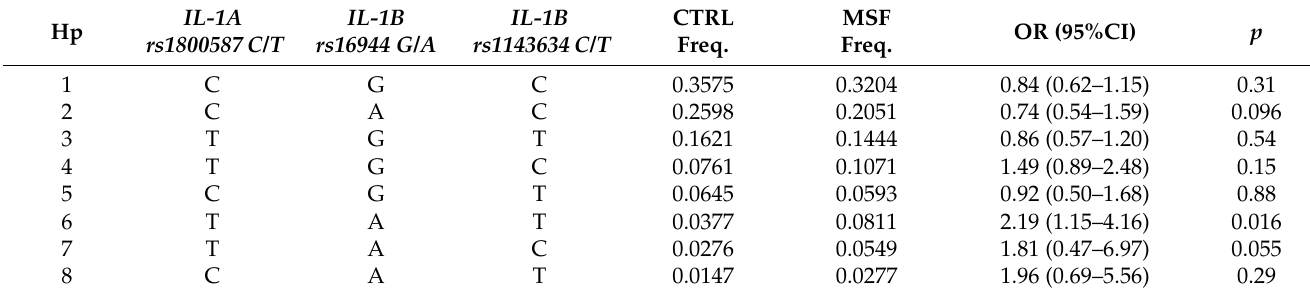
Table 4. Analysis of eight IL-1 gene cluster haplotype (Hp) frequencies (Freq.) in Mediterranean spotted Fever patients (MSF) and healthy controls (CTRL) (adjusted by age and